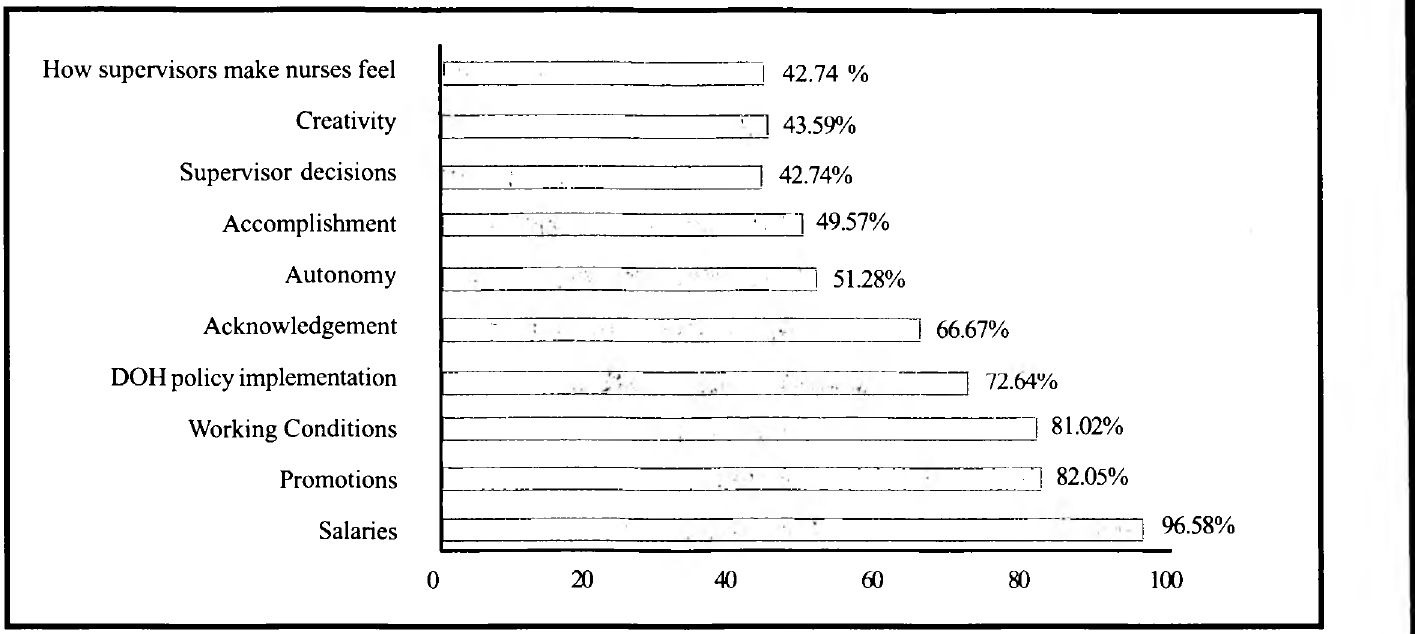
Figure 2: Top ten issues which dissatisfied nurses in a Public Hospital in